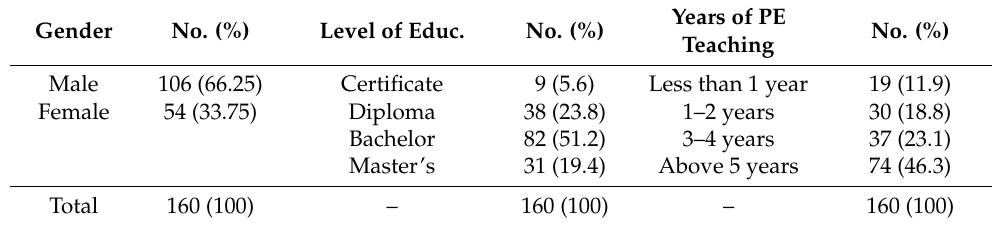
Table 1. Sociodemographic data of PE teachers in terms of gender, level of education, and years of teaching. Gender No. (%) Level of